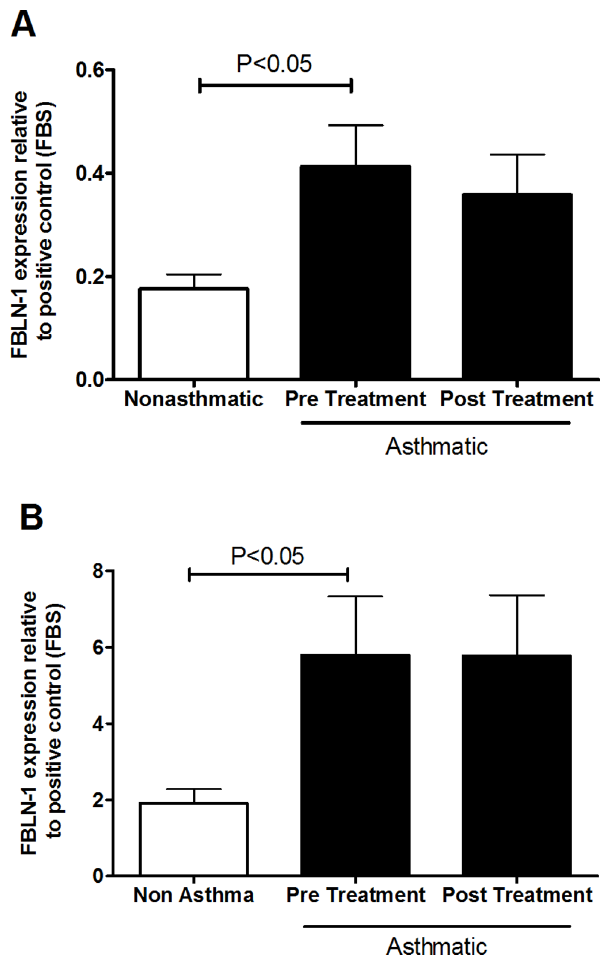
Figure 1. FBLN-1 is increased in the serum and BAL of asthmatics. FBLN-1 levels in serum (A) or BAL fluid (B) from non- asthmatic (white) (n=11) or asthmatic (black, pre and post corticoste- roid treatment, n=20) volunteers. Densitometric values are expressed relative to the positive control FBS. Data are expressed as mean 6 SEM.